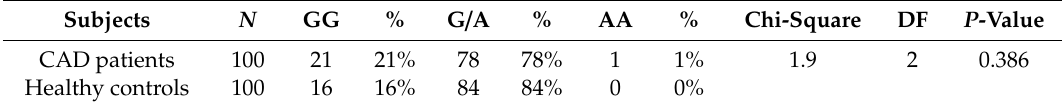
Table 6. The rs2274908 G > A genotype distribution in CAD cases and controls.